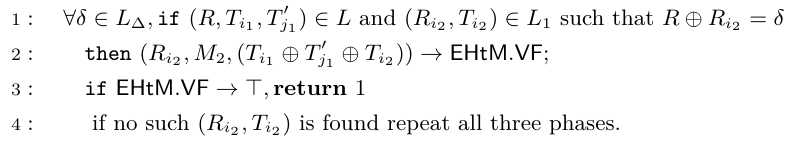
Figure 4.2: SUF adversary A for EHtM